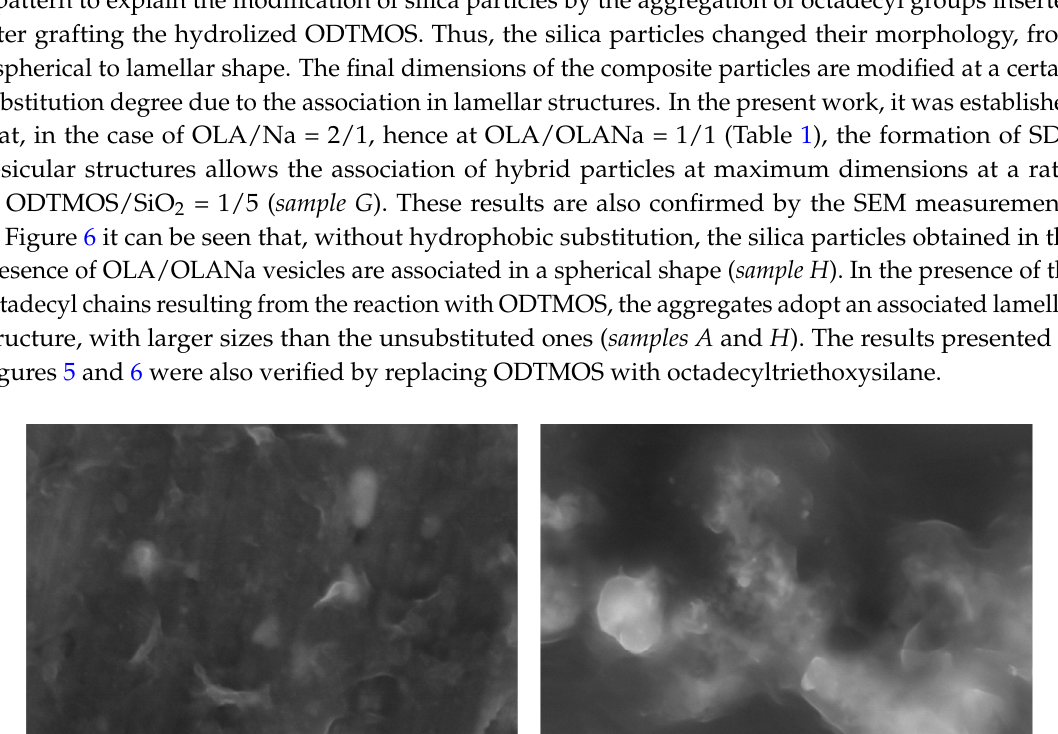
Figure 5. The modification of silica particles (I ) average diameters and ( II ) zeta potential depending on the fraction of ODTMOS.